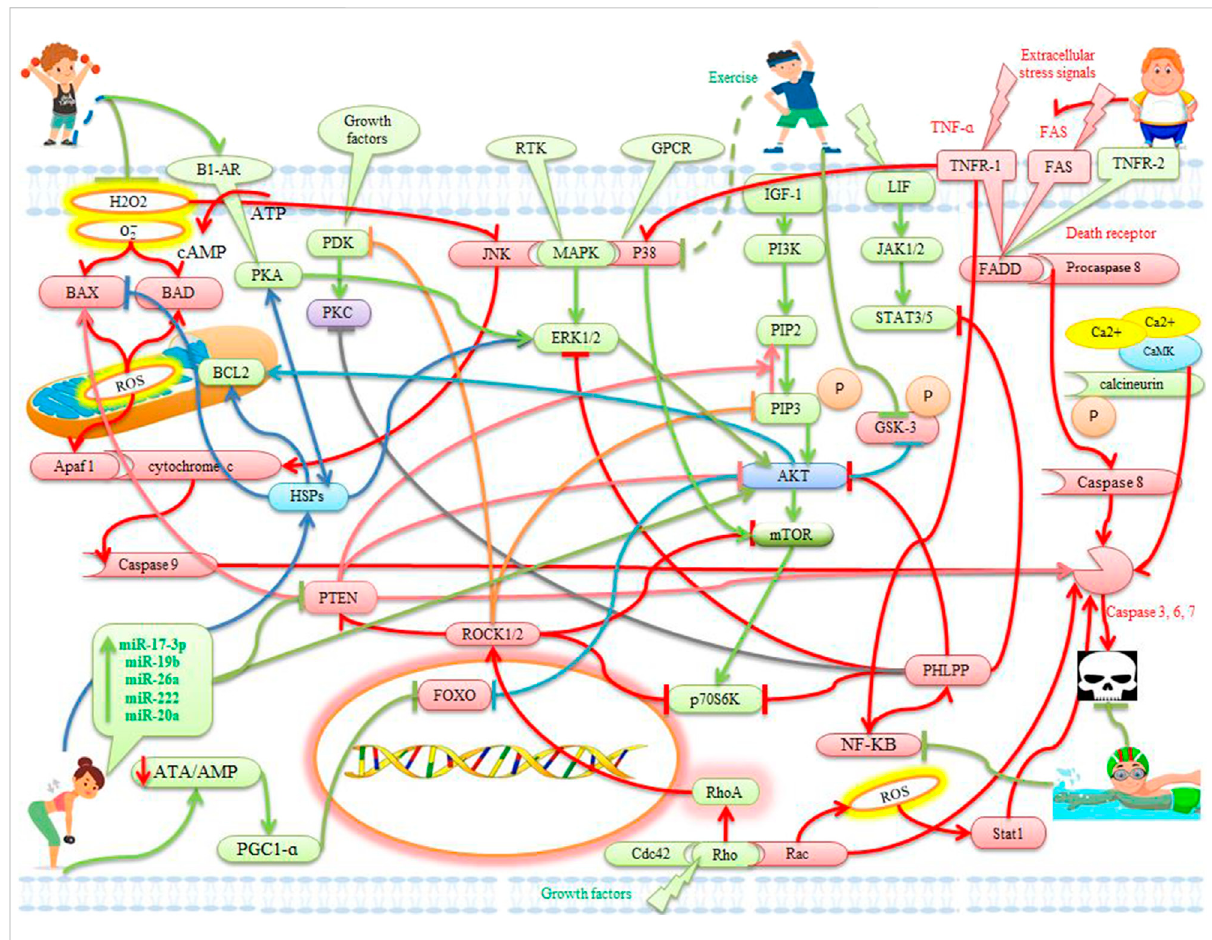
FIGURE 1 The effects of exercise on apoptotic and anti-apoptotic pathways in the heart. Description is available in the text.